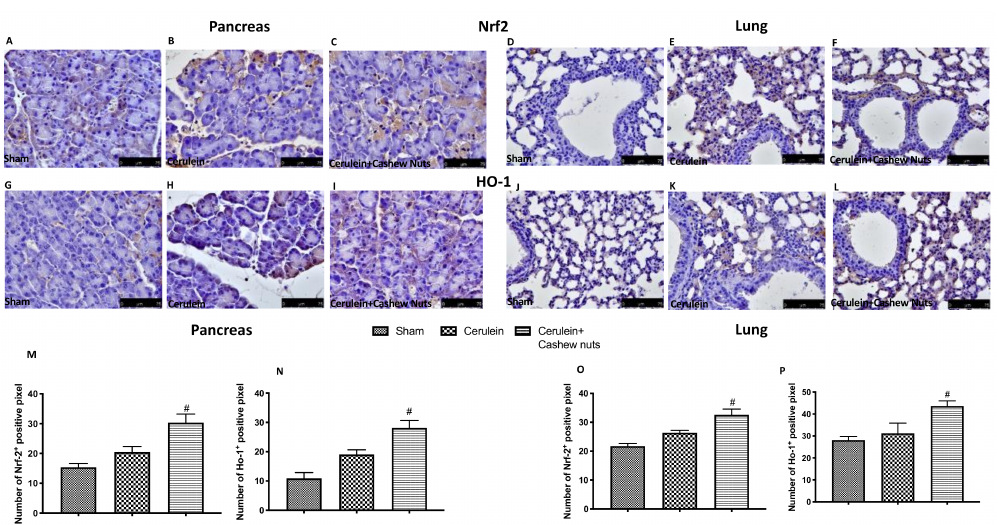
Figure 5. E ff ects of cashew nuts on the Nrf2 pathway in cerulein-induced AP as assessed by immunohistochemistry. Immunohistochemical staining for Nrf2 and HO-1 in pancreatic and lung tissue. Nrf2 immunohistochemical staining in pancreas (( A ) sham, ( B ) cerulein, ( C ) cerulein + cashew nuts) and lung (( D ) sham, ( E ) cerulein, ( F ) cerulein + cashew nuts), and relative densitometric quantification in pancreas ( M ) and lung ( O ). HO-1 immunohistochemical staining in pancreas (( G ) sham, ( H ) cerulein, ( I ) cerulein + cashew nuts) and lung (( J ) sham, ( K ) cerulein, ( L ) cerulein + cashew nuts) and relative densitometric quantification in pancreas ( N ) and lung ( P ). Values shown are means ± SEM of 6 mice. # p < 0.05 vs. cerulein.